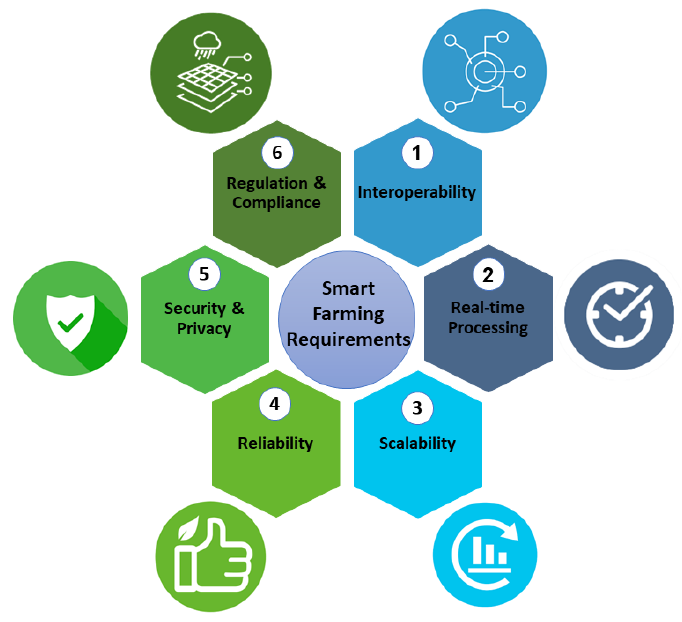
Figure 2. Platform requirements for data processing.